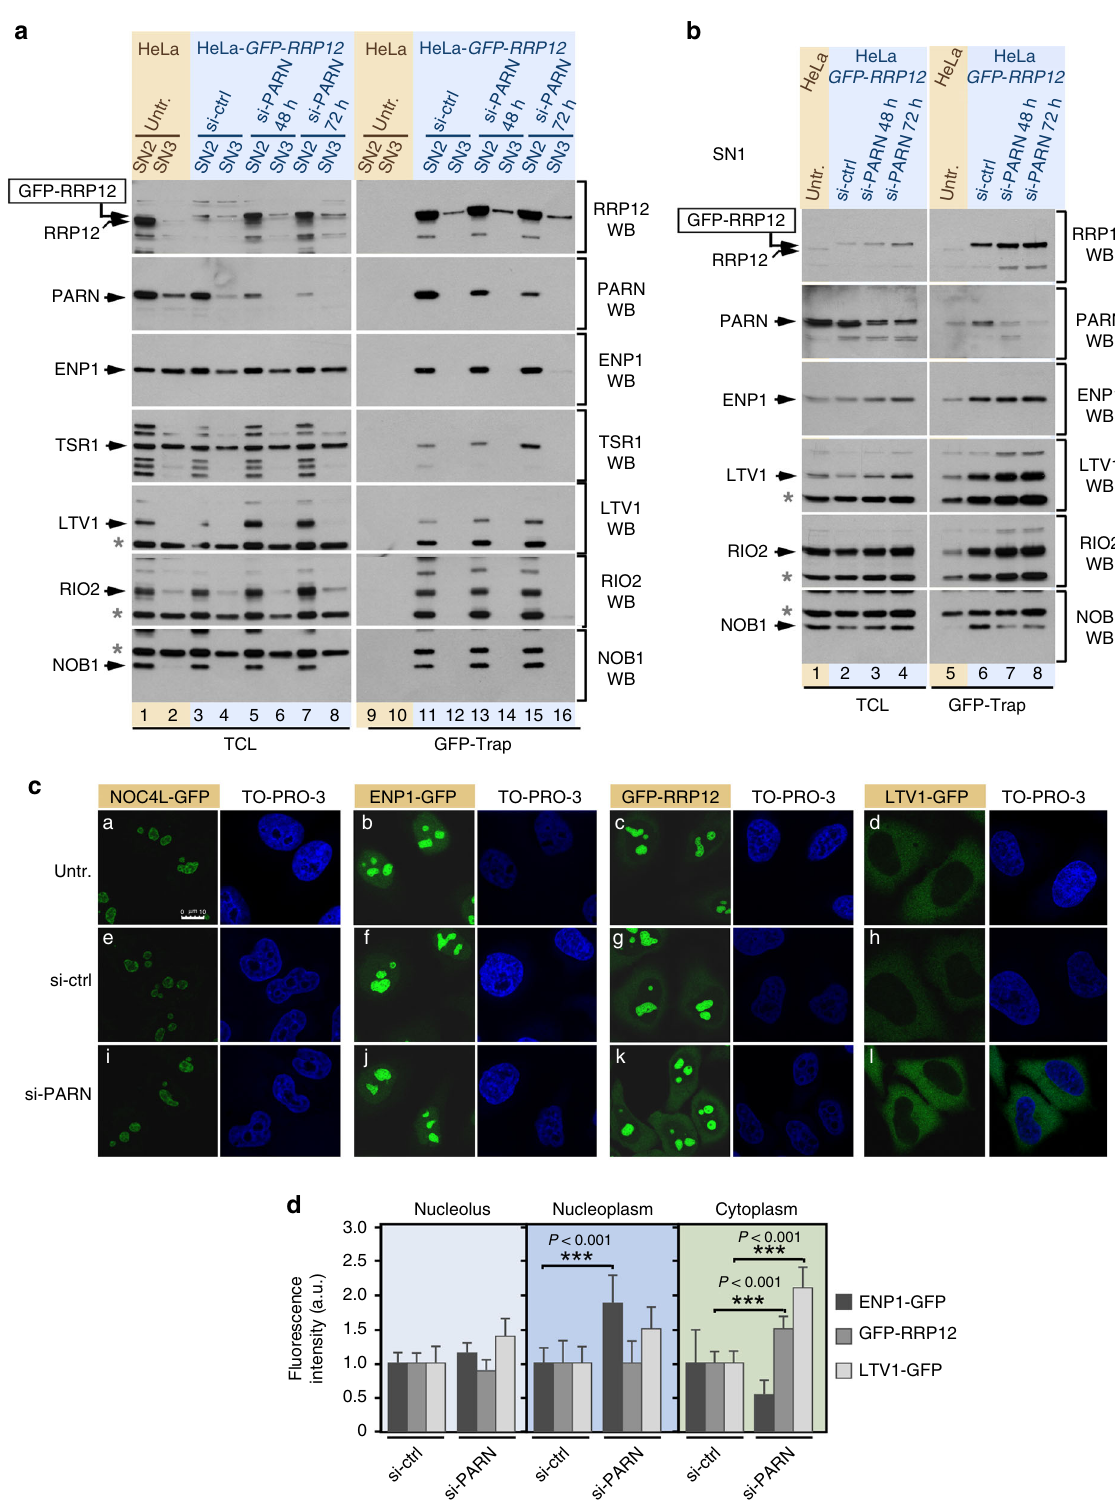
compromises the fi nal pre-40S particle recon fi guration, as demonstrated by the block in the release of LTV1 but not of NOB1 from those particles. Altogether, these data indicate that PARN is a bona fi de 40S subunit maturation factor that is required for the completion of a RRP12-mediated maturation step that precedes the late-maturation phase of pre-40S particles in the